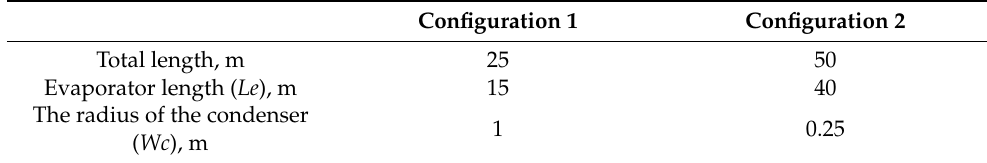
Table 4. Heat pipe